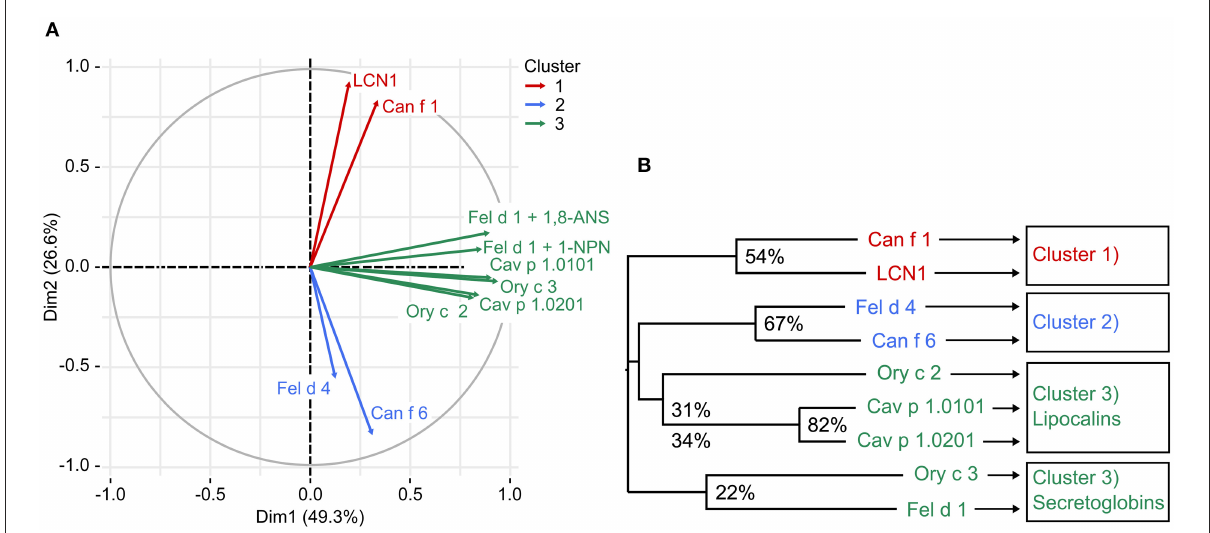
FIGURE7 (A) Principle component analysis (PCA) identified three clusters of mammalian respiratory allergens with similar ligand binding behavior based on fluorescence inhibition values of forty-nine ligands (thirty-two for 1-NPN). Cluster 3 contains 2 proteins families, lipocalins and secretoglobins, that are unrelated in sequence. (B) Phylogenetic tree represents the relationships between eight mammalian respiratory allergens and human LCN1 based on a multiple amino acid sequence alignment. Amino acid sequence identity between cluster members is presented in percentage values.